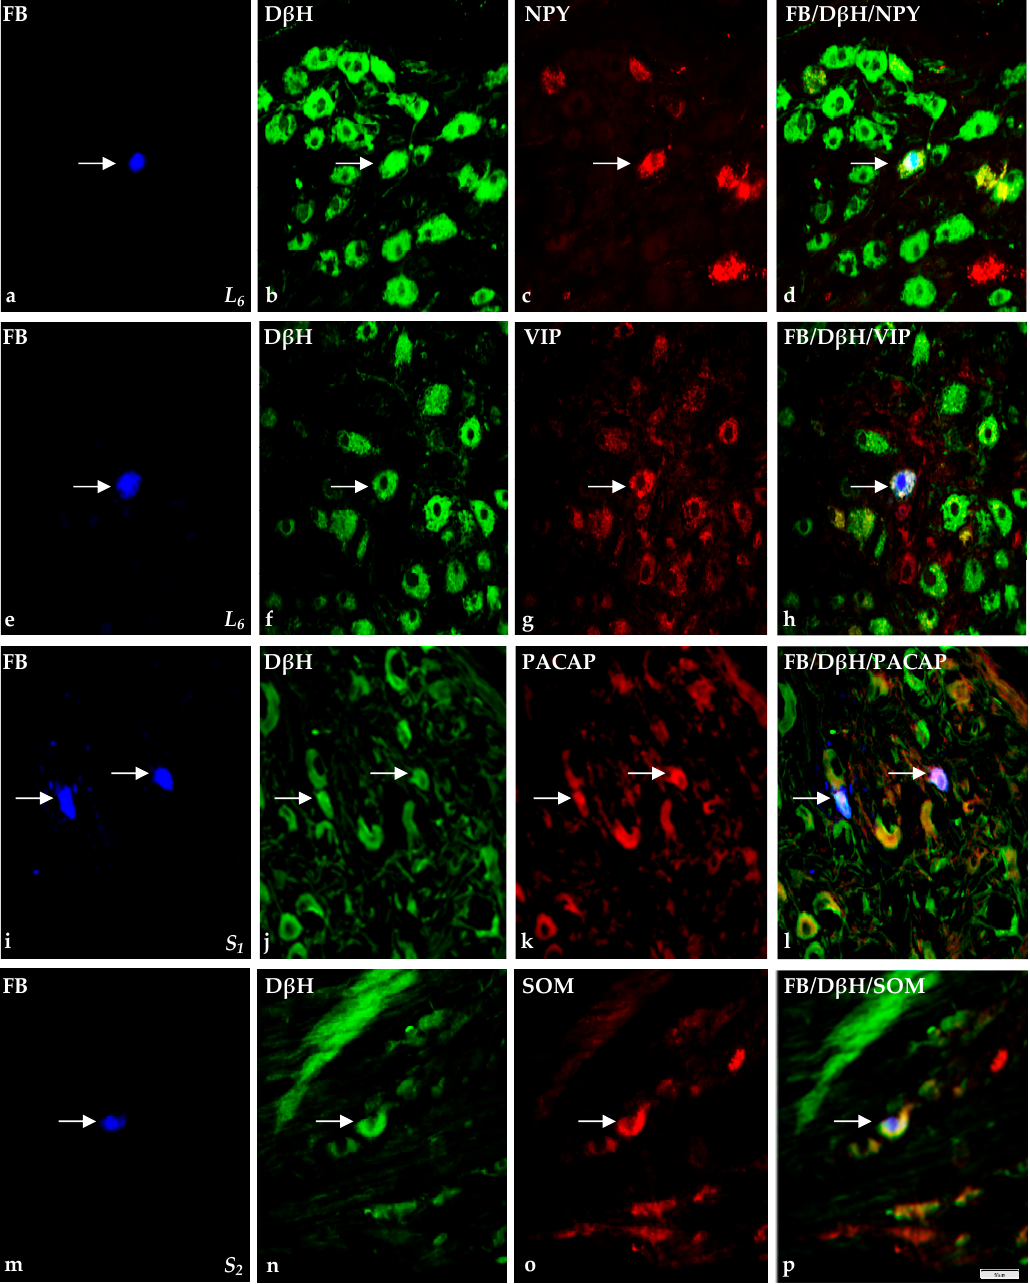
Figure 5. Representative images of sympathetic chain ganglia skin-projecting neurons in porcine skin hind leg. The arrow indicates Fast blue-positive (FB + ) skin perikaryon containing examined substances. All the images are taken separately from blue (FB + ( a , e , i , m )), green (D β H + ( b , f , j , n )) and red (positive for: NPY ( c ); VIP ( g ); PACAP ( k ); and SOM ( o )) fluorescent channels. Microphotographs d , h , l , p showing the over position of all three channels simultaneously. In L 6 ganglion, FB + small-sized neurons ( a , e ) which were simultaneously D β H + ( b , f ) as well as NPY + ( c ) and VIP + ( g ). Two small-sized FB + neurons ( i ) containing simultaneously D β H ( j ); and PACAP ( k ) in S 1 SChG. Visible one FB + small-sized neuron ( m ) containing D β H ( n ) and SOM ( o ) in S 2 SChG. Scale bar = 50 µm.